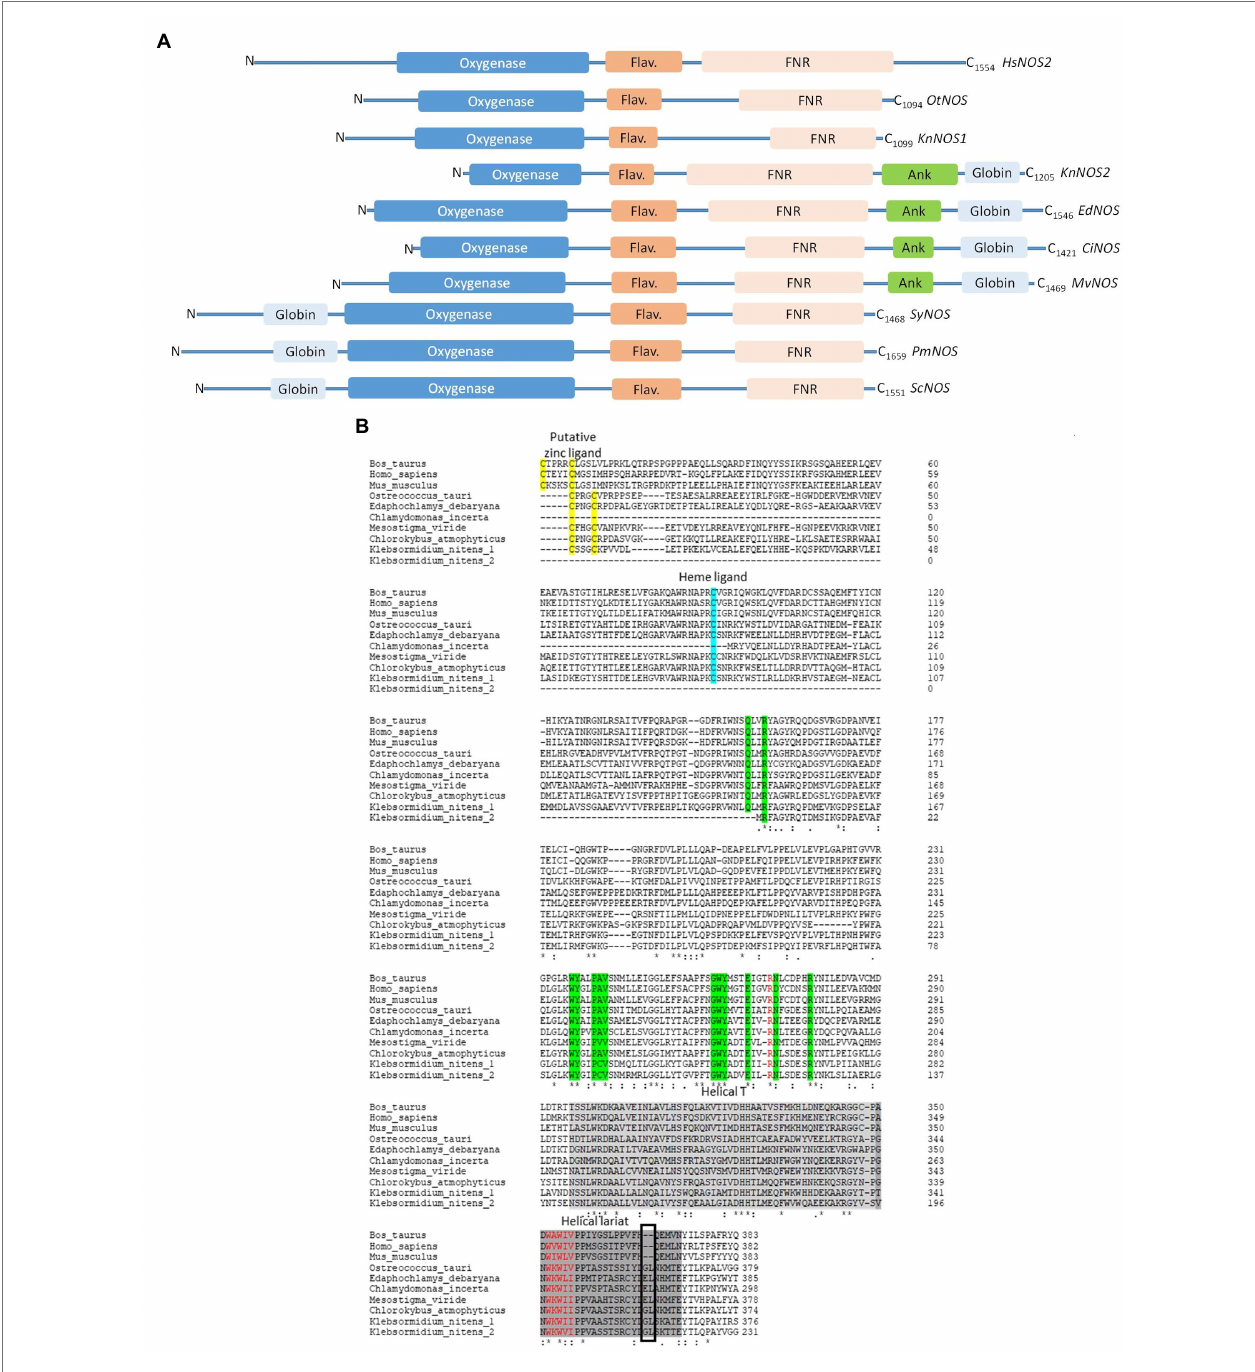
FIGURE 2 | (A) Schematic representation of primary sequences of NOS-like proteins from Homo sapiens ( HsNOS2 , AAB60654), Ostreococcus tauri ( OtNOS, OUS45267), Klebsormidium nitens ( KnNOS1, KFL_000760350 at the top and KnNOS2, KFL_006460015 at the bottom), Edaphochlamys debaryana ( EdNOS, KAG2495438), Chlamydomonas incerta ( CiNOS, KAG2438015), Mesostigma viride ( MvNOS, Mv7497-RA-2, Joint Genome Institute PhytoCosm), Synechococcus sp. ( SyNOS, WP_006458277), Pseudo-nitzschia multistriata (PmNOS), and Skeletonema costatum (ScNOS). Three NOSs share a common oxygenase domain (blue). The FMN domain is represented by a dark orange flavodoxin module (Flav.) and the FAD/NADPH domain is represented by a light orange FNR box. Additional domains comprise a globin domain (light blue box), an ankyrin-repeat domain (Ank, green). Conserved domains have been identified thanks to NCBI and domains alignment analyzed through Clustal Omega. (B) Comparative analysis of NOS oxygenase domains from Bos Taurus (AAA30669.1), Homo sapiens ( HsNOS2 , AAB60654), Mus musculus (AAA39834.1), Ostreococcus tauri (OUS45267), Edaphochlamys debaryana (KAG2495438), Chlamydomonas incerta (KAG2438015), Mesostigma viride ( MvNOS, Mv7497-RA-2, Joint Genome Institute PhytoCosm), Chlorokybus atmophyticus ( CaNOS , chrsp63S00556, Joint Genome Institute PhytoCosm), and K. nitens (1, KFL_000760350 and 2, KFL_006460015). Arginine binding residues are colored in green. The black box highlights the insert observed in the helical lariat of non-mammalian NOSs. Alignment has been performed through Clustal